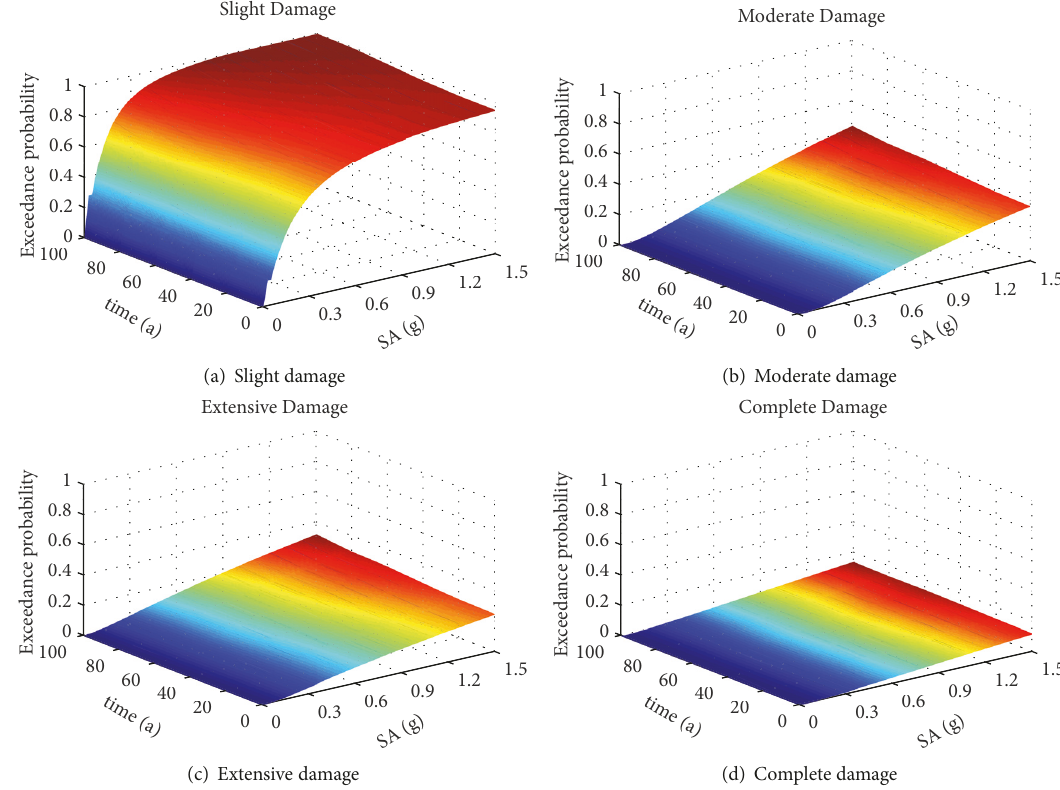
Figure 19: The vulnerability surfaces of 4 # bearing under different damage states.